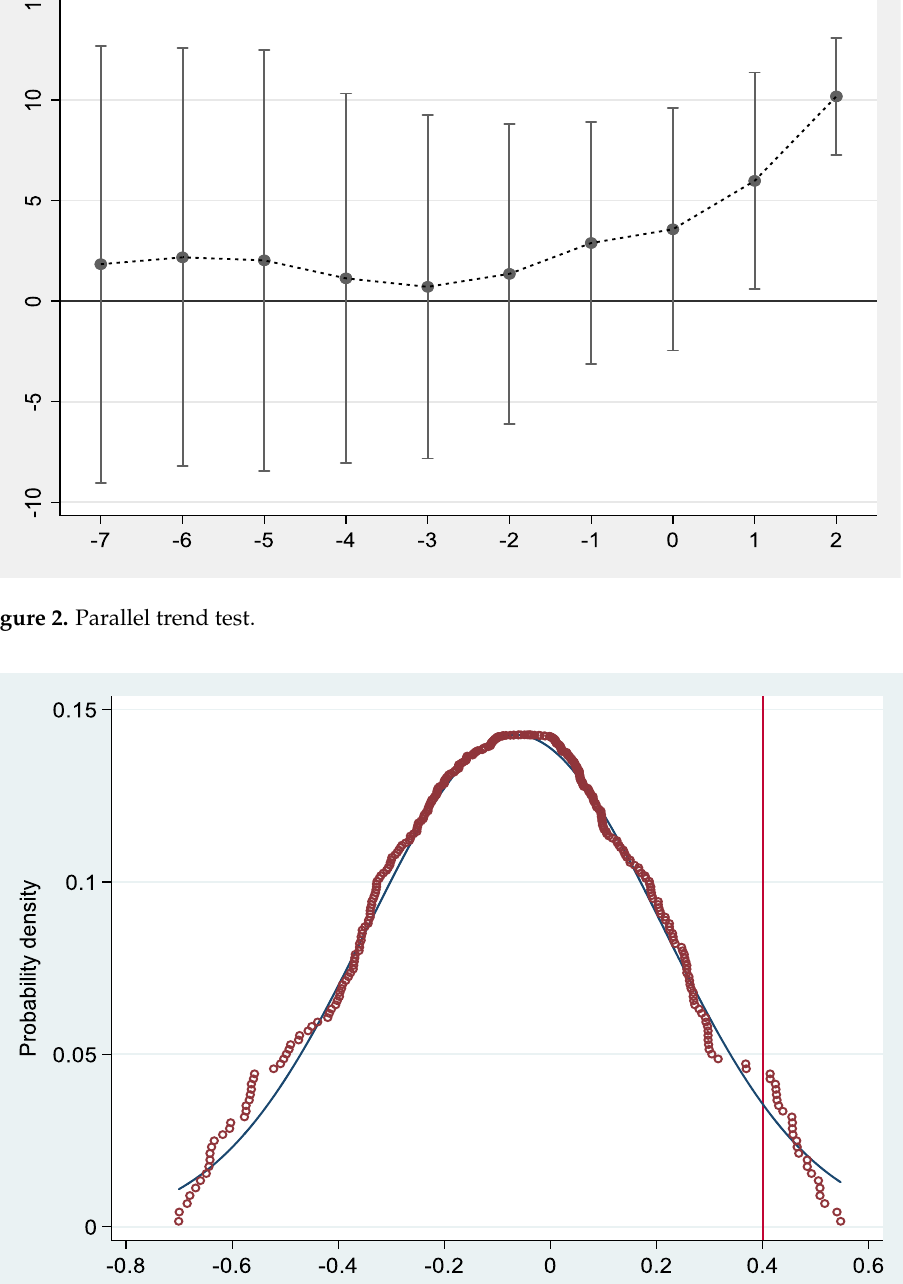
Figure 3. Placebo